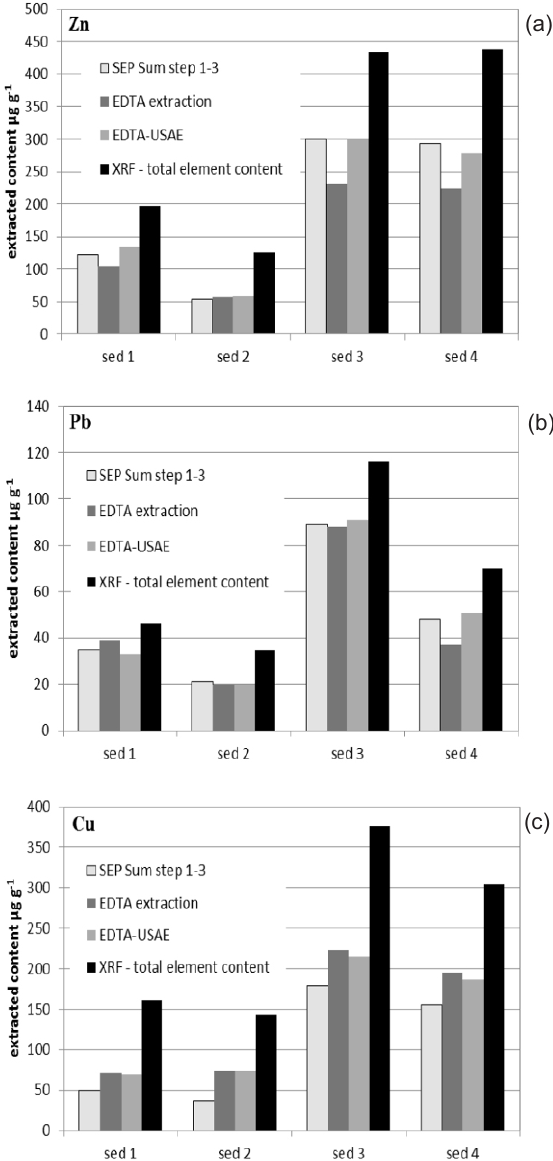
Figure 2. The comparison of the Zn, Pb and Cu determination of conventional EDTA extraction, EDTA-USAE (columns labeled – EDTA extraction, and EDTA-USAE) and summary contents of the first three steps of the SEP (column labeled – SEP Sum step 1-3). Results of total content analyses performed by XRF (column labeled – XRF-total element